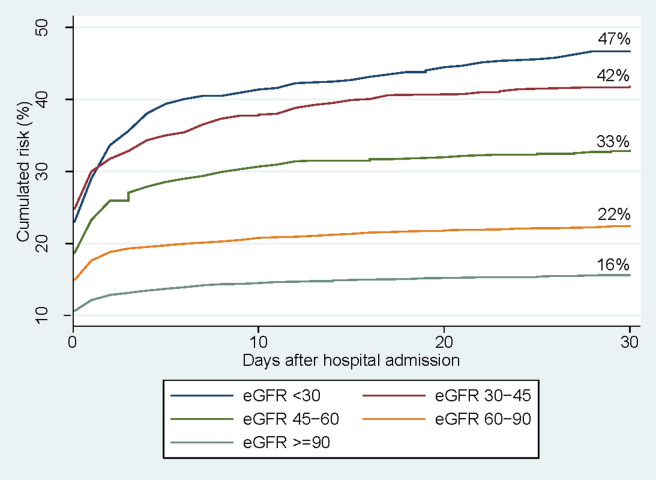
The cumulative 30-day risk of acute kidney injury after admission with pyelonephritis by different preadmission eGFR categories.Abbreviations: eGFR, estimated glomerular filtration rate.